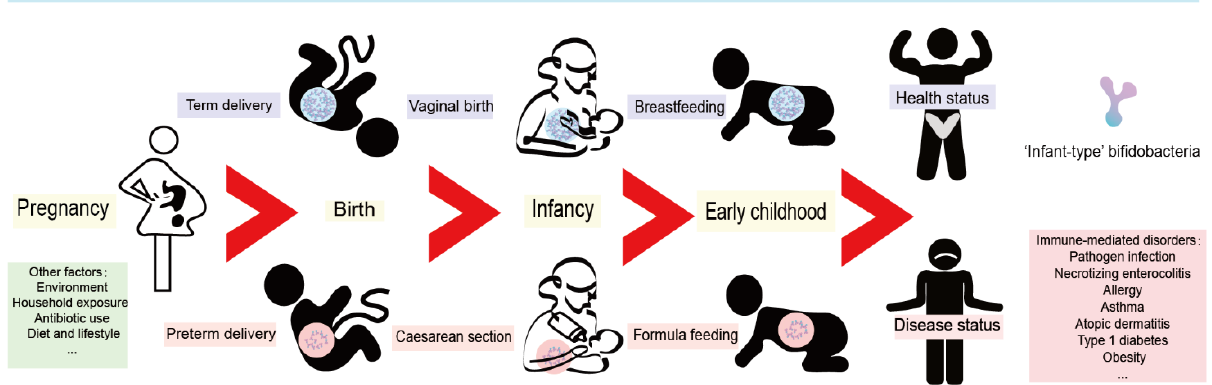
Figure 1. Intestinal infant-type bifidobacteria mediate immune system development in the first 1000 days of life. The mode of delivery and feeding exert the most pronounced roles in the colonization of infant-type bifidobacteria in the first 1000 days. Pregnancy, environment, household exposure, antibiotic use, diet, and lifestyle all have a far-reaching impact on the composition of infant intestinal flora. Interfering with the colonization of infant-type bifidobacteria in early life leads to long-term and far-reaching health consequences, especially mediating the occurrence and development of a variety of immune-mediated disorders, including pathogen infection, necrotizing enterocolitis (NEC), allergy, asthma, atopic dermatitis, type 1 diabetes mellitus (T1D) and obesity.